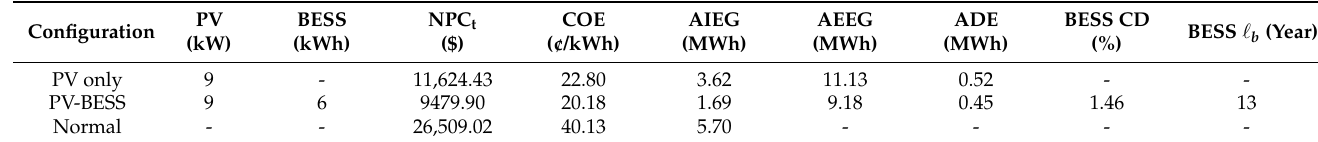
Table 7. Optimal results for both system configurations with Option 2